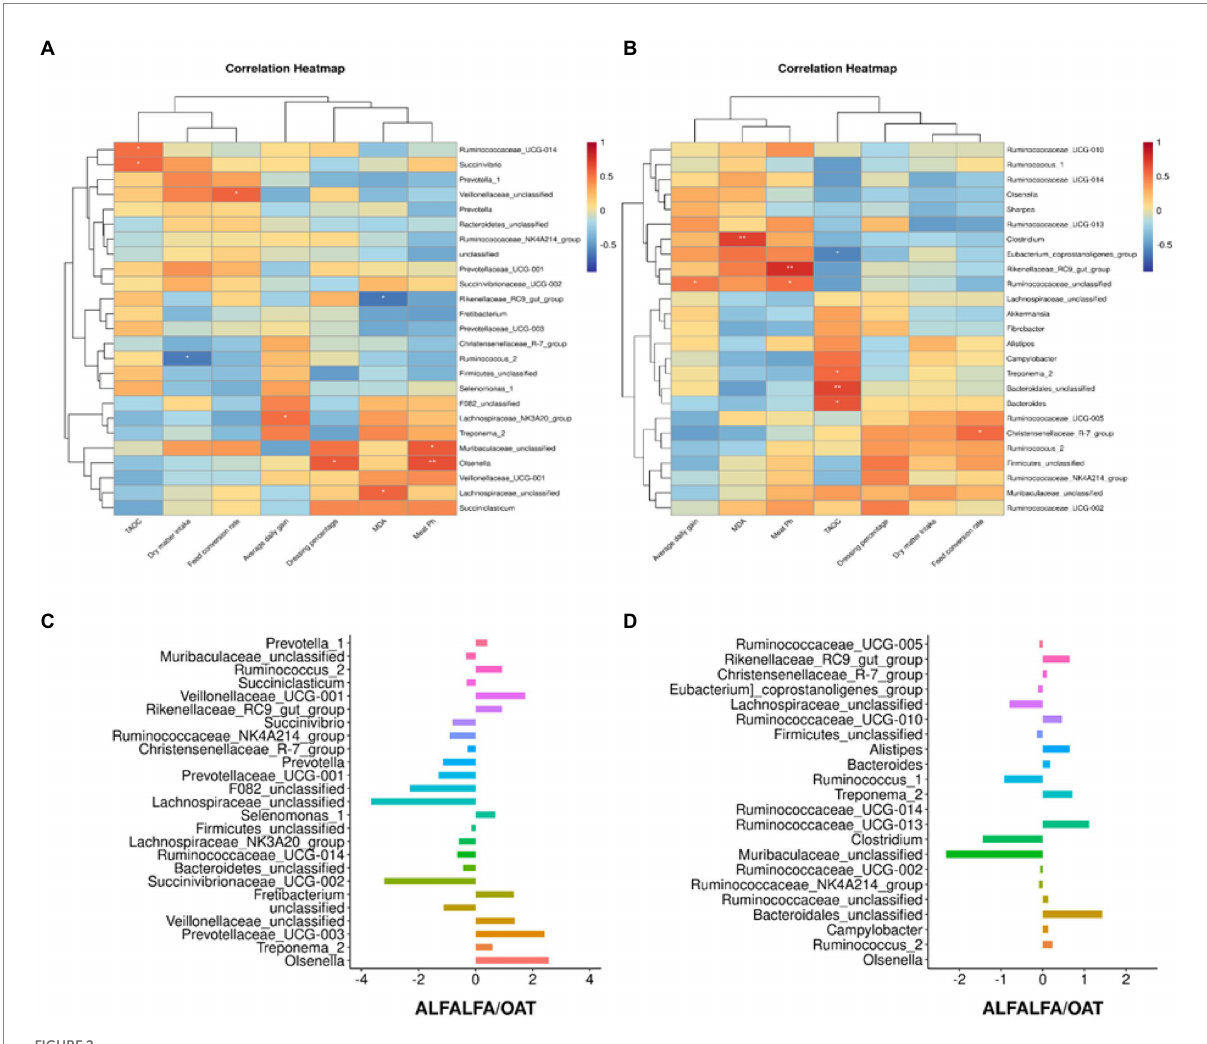
FIGURE 2 Effects of changes in the dominant microbiome of alfalfa and oat on growth performance and meat quality. (A) Heatmaps of Pearson’s correlations between rumen dominant genera and growth performance and meat quality. (B) Heatmaps of Pearson’s correlations between intestinal dominant genera and growth performance and meat quality. (C) Differential rumen genus microbiome between alfalfa and oat. (D) Differential intestinal genus microbiome between alfalfa and oat, * p < 0.05, ** p <